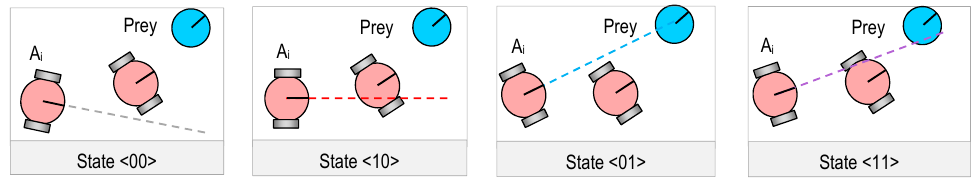
Figure 1. The four possible environmental states perceived by (any) predator agent Ai.